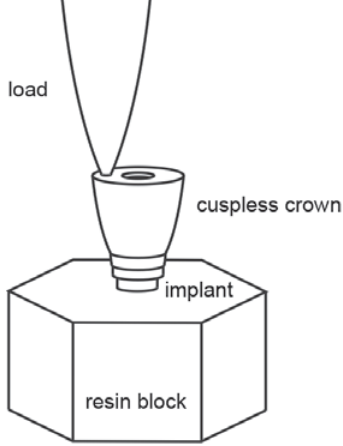
Figure 5- Scheme of application of non-axial loading of cyclic loading test on the specimens where F is the force applied and S is the